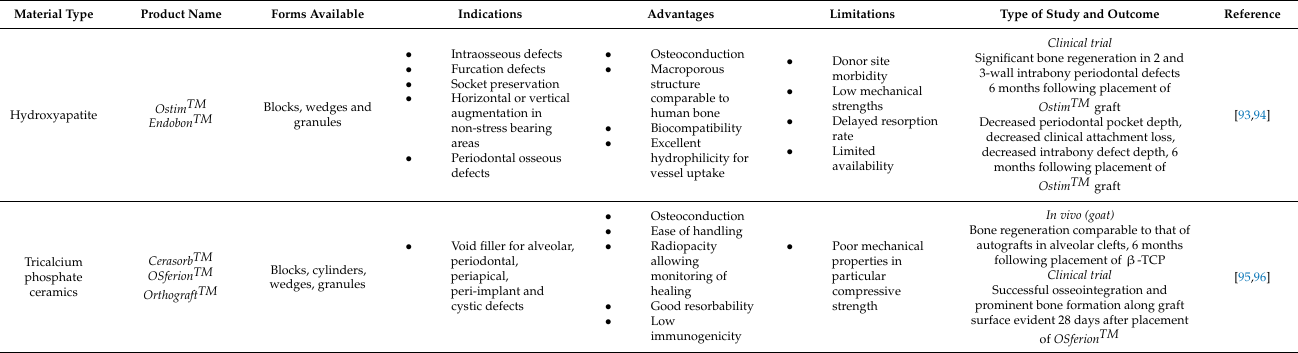
Table 2. Characteristics of synthetic bone grafting